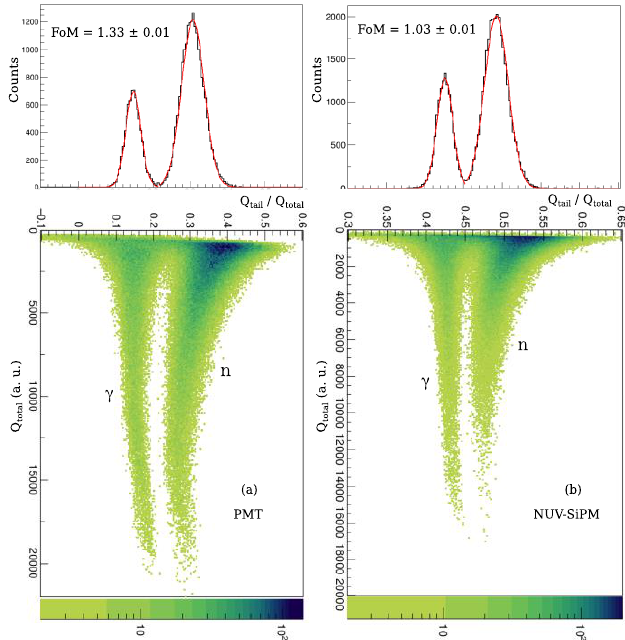
Fig. 7. 2D plots, PSP versus Q total , corresponding to the measurements using the Am-Be source with the EJ-276 (25 mm dia. x 25 mm thick.) coupled to the PMT (a) and to the NUV-SiPM array (b). PSP distributions and FoM values (at ~1 MeVee) are reported on